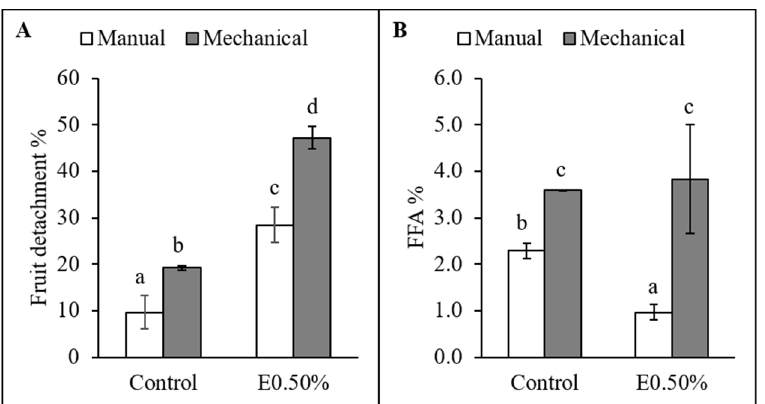
Figure 3. Mechanical stripping of ethephon-treated oil palm bunches by rotating threshing. ( A ) Fruit detachment (%) and ( B ) FFA content of oil palm bunches treated with 0.50% ( v / v ) ethephon for 24 h applied by evaporation method before threshing (manual) and after threshing (mechanical). The data are presented as means of the replicates ( n = 5) and vertical bars indicate standard deviation. Means that do not share a letter are significantly different at p < 0.05 according to Tukey’s range test.